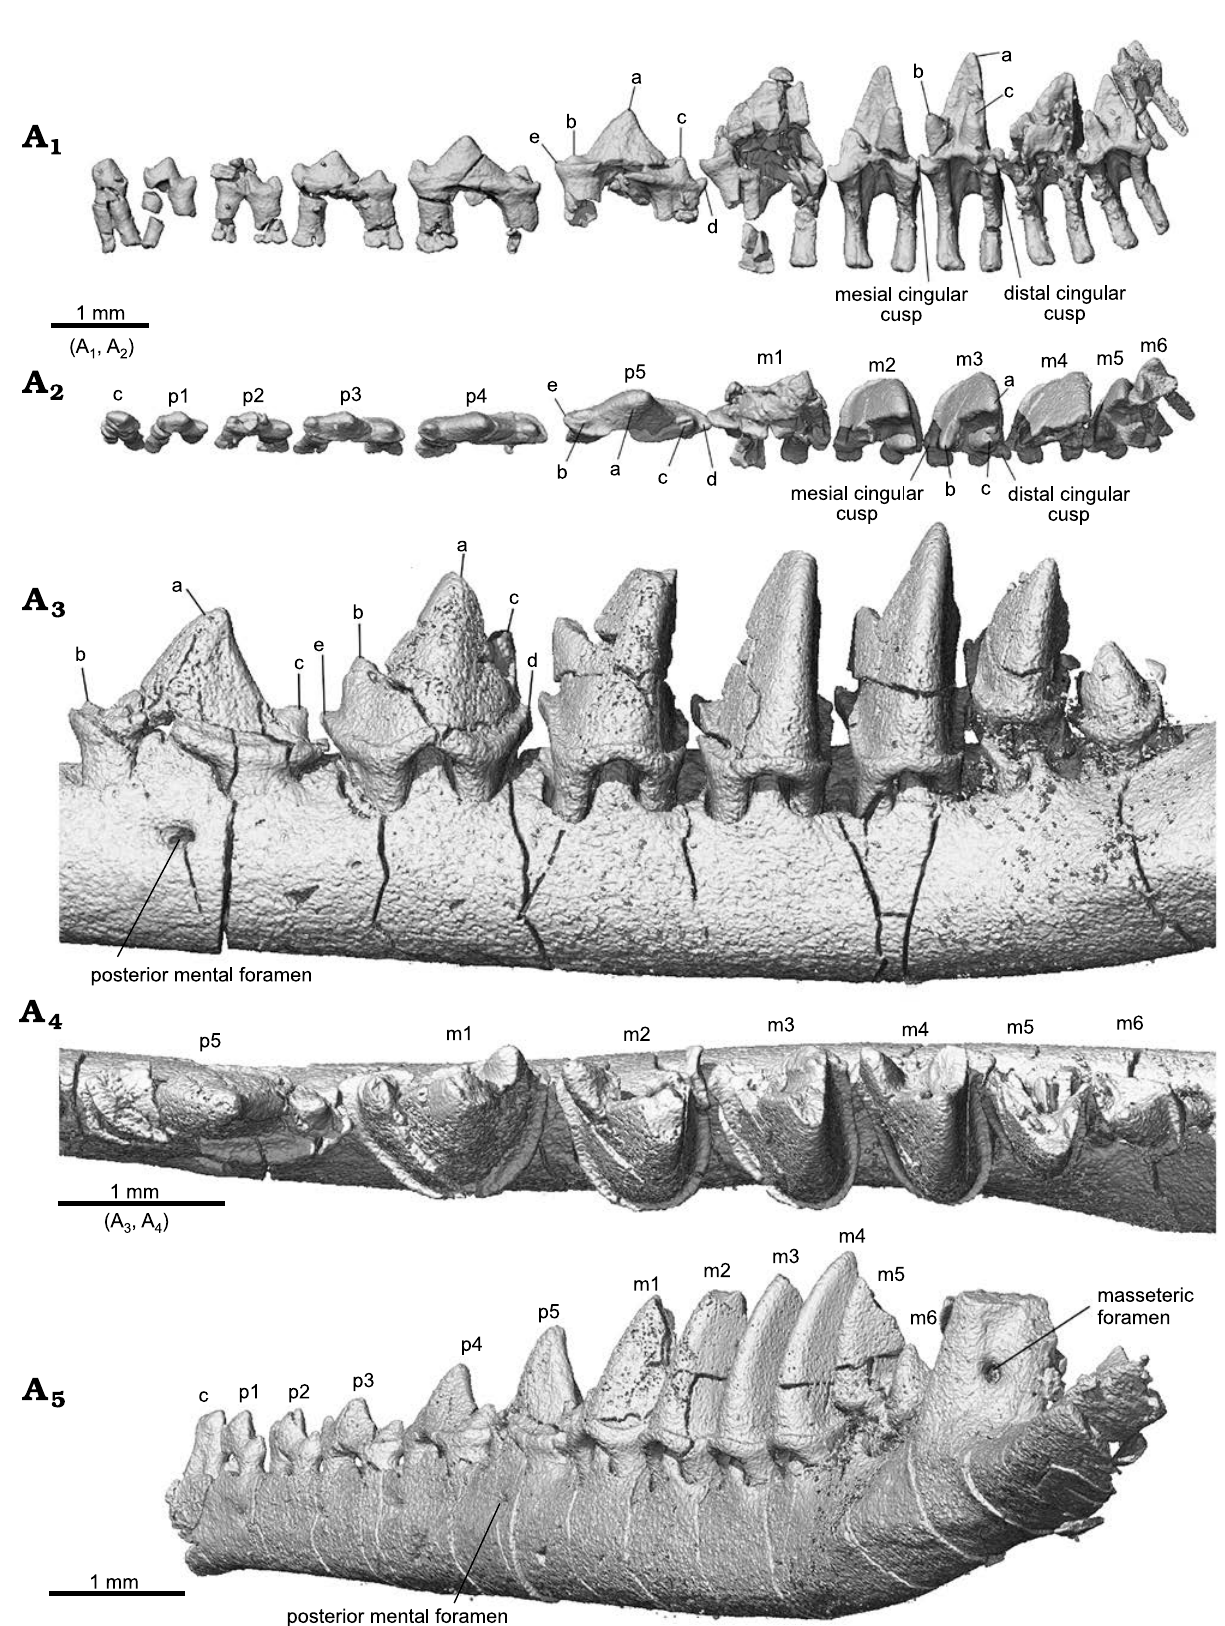
Fig. 5. Lower teeth of the trechnotherian mammal Lactodens sheni Han and Meng, 2016 (ZGY0053) from Aptian, Lower Cretaceous Jiufotang Formation of Daping fang, Caoyang City, Liaoning Province, China), right c–m6 in lingual (A 1 ) and occlusal (A 2 ) views (with the dentary bone segmented away) and in posterobuccal view (A5), left p5–m6 in buccal (A 3 ) and occlusal (A 4 ) views. See also Figs. 3 and